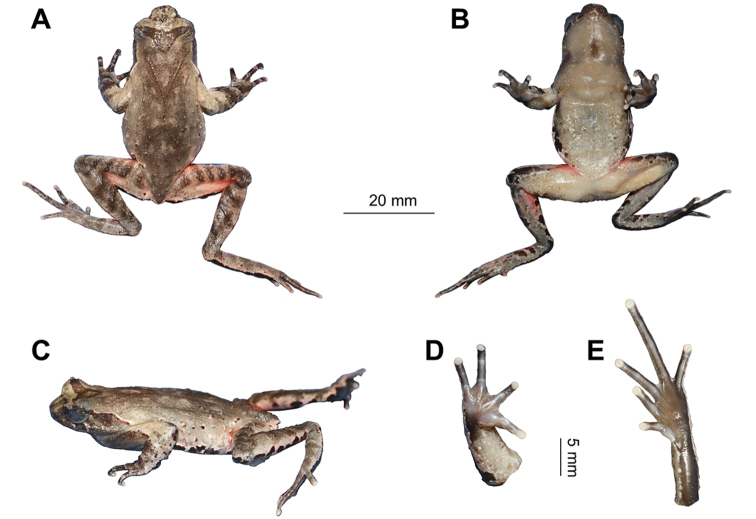
The holotype specimen CIBCS20190518031 of Megophrys
chishuiensis sp. nov. A dorsal view B ventral view C lateral view D ventral view of hand E ventral view of foot.